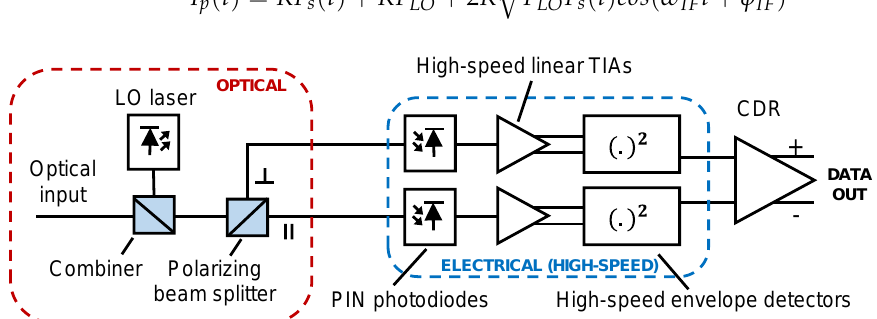
Figure 1. Block diagram of a quasi-coherent receiver architecture with polarization